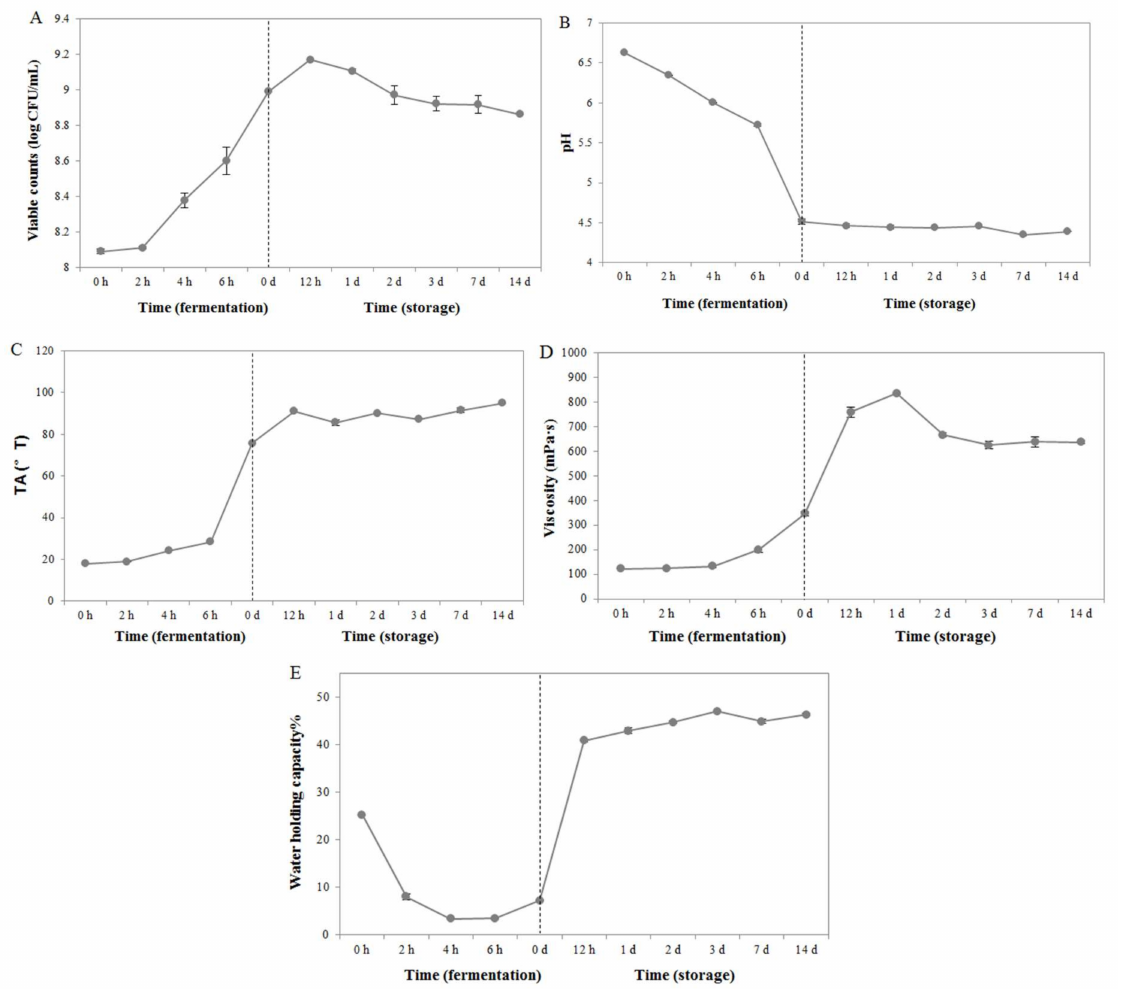
Figure 1. The physiochemical characteristics of milk fermented by S. thermophilus MGA45-4 during fermentation (0 h, 2 h, 4 h, and 6 h) and storage (0 d, 12 h, 1 d, 2 d, 3 d, 7 d, and 14 d). The parameters analyzed included ( A ) the count of viable S. thermophilus MGA45-4 cells, ( B ) pH, ( C ) titratable acidity, ( D ) viscosity, and ( E ) water-holding capacity of the fermented milk